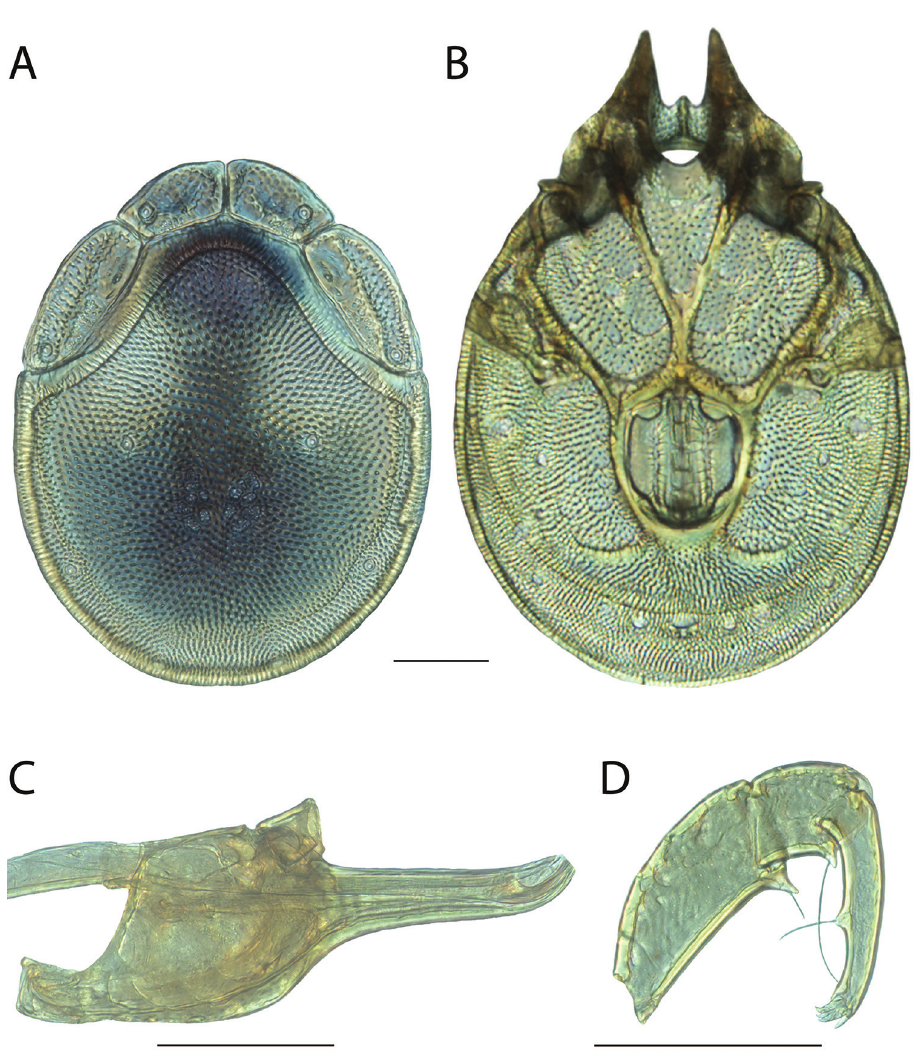
Figure 151. Torrenticola mjolniri sp. n. male: A dorsal plates B venter (legs removed) C subcapitulum D pedipalp (setae not accurately depicted). Scale = 100